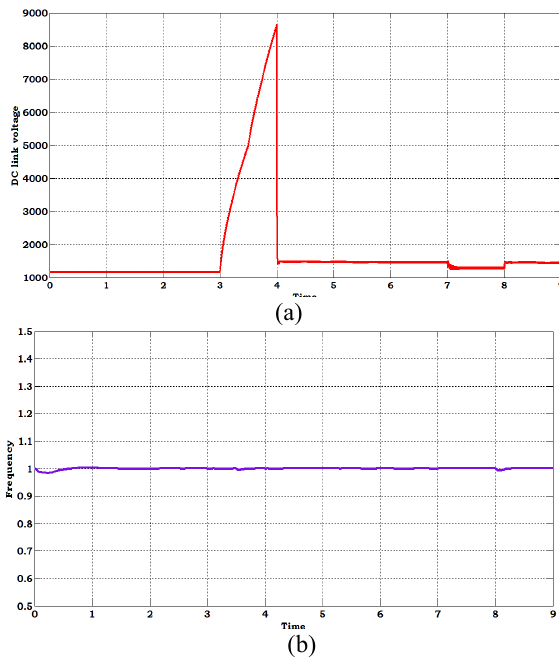
Figure 12. (a). DC link voltage, (b).Frequency Sudden transient occurred at t=3 sec to 4 sec and fault occurred at t=7 sec but still fuzzy controller is maintaining constant DC link voltage and frequency.